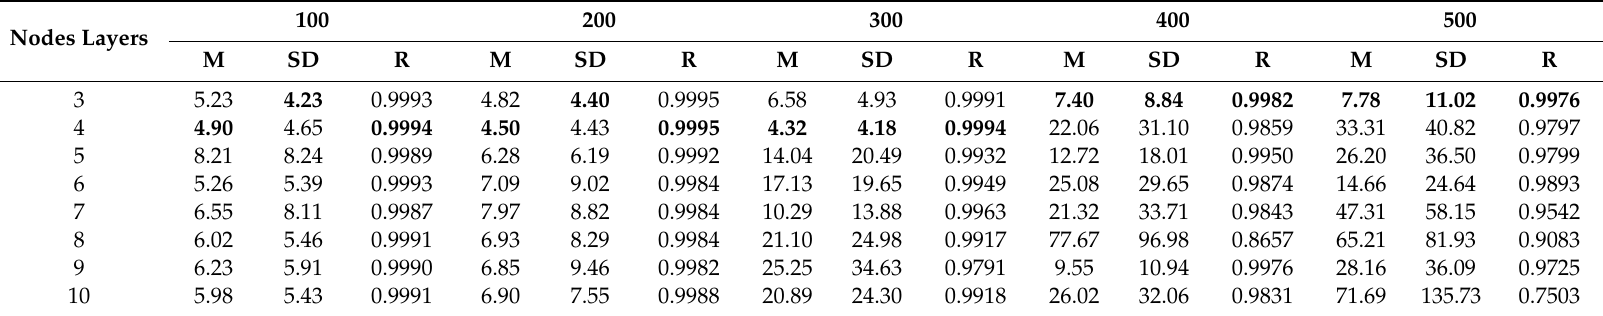
Table 1. Summary of the retrieval errors for obtaining the MNDWI. (M: mean error, R: correlation coe ffi cient, and SD: standard deviation of the fit). The actual value of M and SD are the value in the table times 10 − 3 . For all columns, the minimum M with maximum R and minimum SD is indicated in bold. Nodes Layers